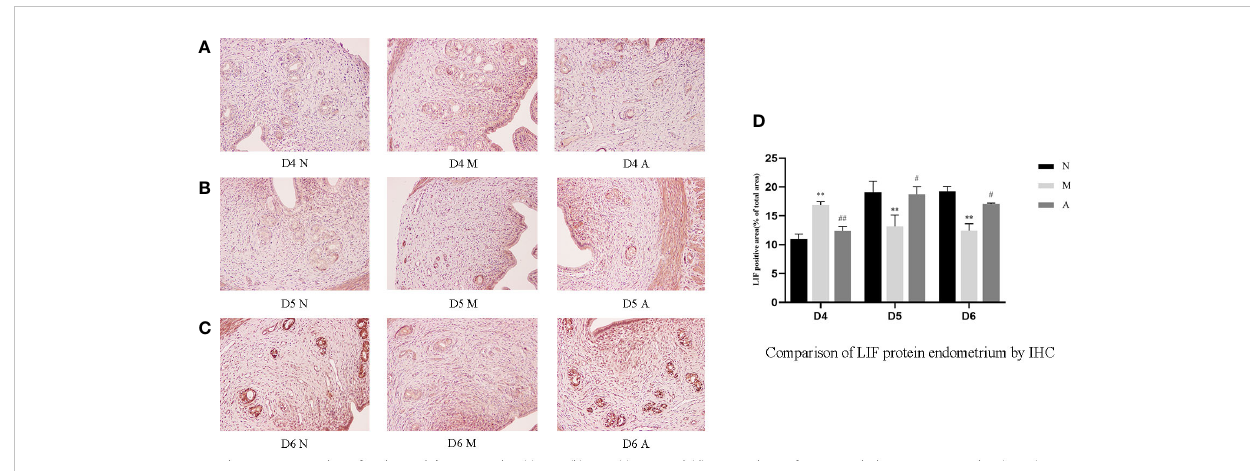
FIGURE 3 The expression of endometrial LIF protein: (A) D4; (B) D5; (C) D6; and (D) comparison of LIF protein by mean gray value (n=3). *or** represents that there is signi fi cant difference between M and N groups ( P < 0.05 or P < 0.01), #or ## represents that there is signi fi cant difference between A and M groups ( P < 0.05 or P < 0.01). Original magni fi cation *200. LIF, Leukemia inhibitory factor; IHC, Immunohistochemistry; D, The embryo day; D4 N, D4 normal group; D4 M, D4 model group; D4 A, D4 acupuncture group; D5 N, D5 normal group; D5 M, D5 model group; D5 A, D5 acupuncture group; D6 N, D6 normal group; D6 M, D6 model group; D6 A, D6 acupuncture group; N, Normal group; M, Model group; A, Acupuncture